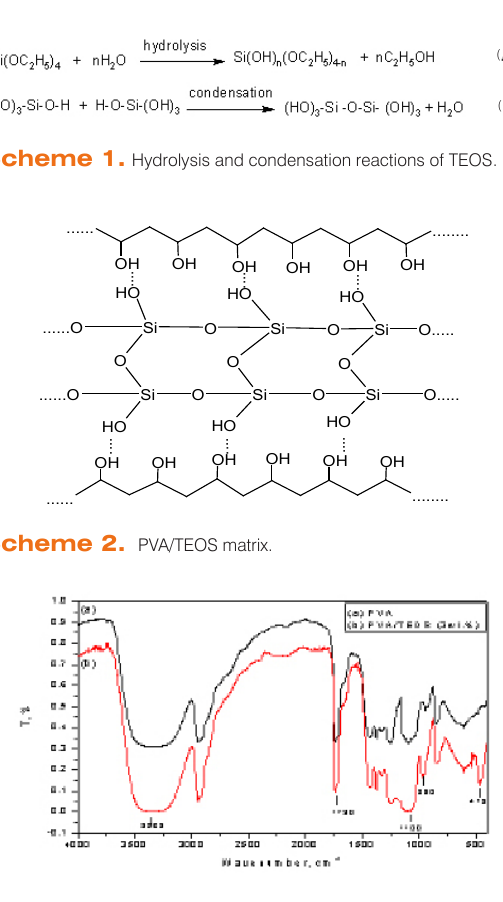
Figure 1. FTIR spectrum of PVA/3 wt% TEOS matrix.